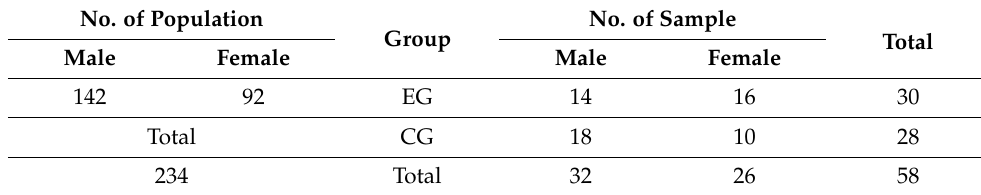
Table 3. The Population and Sample of Study.